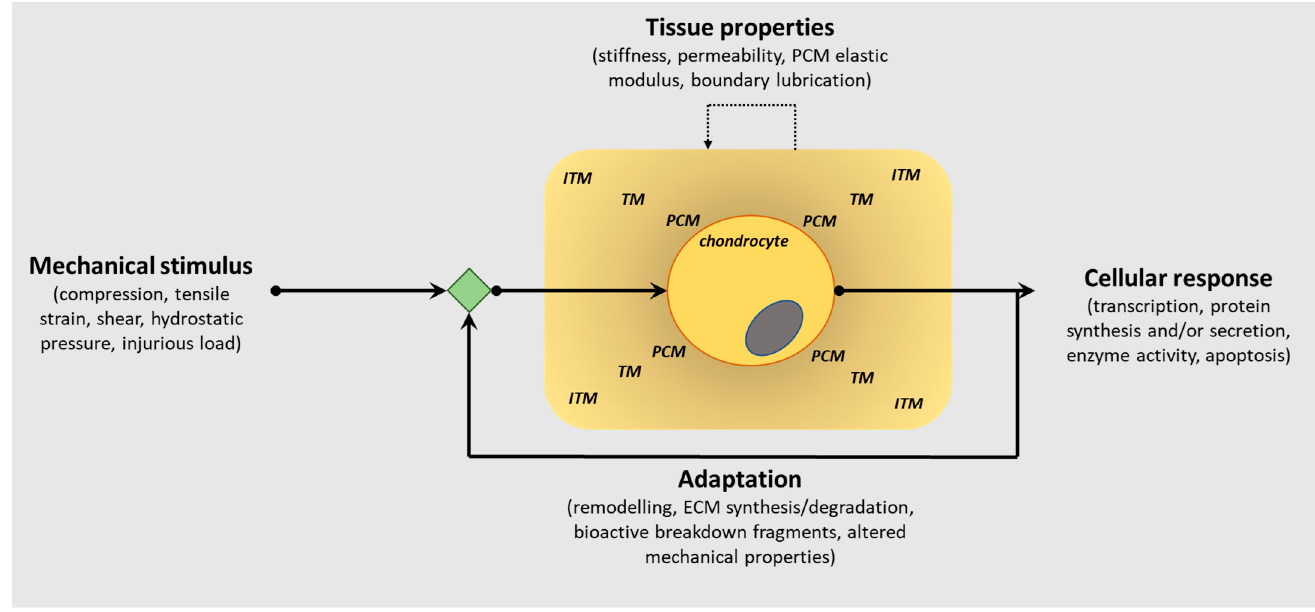
Figure 1. Schematic representation of the bidirectional reciprocity of the pericellular/extracellular matrix (ECM) in chondrocyte mechano-signalling and articular cartilage homeostasis. This bidirectionality within the extracellular matrix (ECM) is critically important in enabling the chondrocytes to sense load application, including altered loading patterns, but also to influence PCM/ECM composition as a consequence of mechanical cues to regulate the structural, biomechanical and functional characteristics of articular cartilage in tissue health and pathology. (PCM, pericellular matrix; TM, territorial matrix; ITM, interterritorial matrix.)